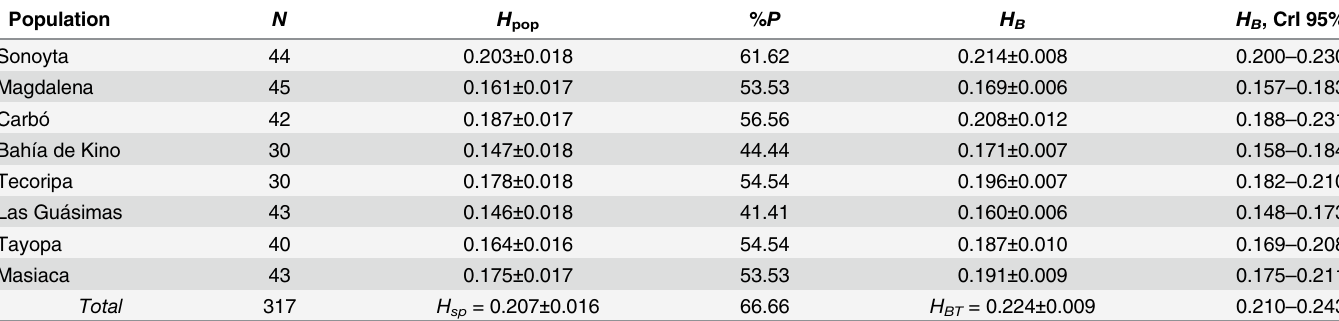
Table 2. Total and within population genetic variation in Stenocereus thurberi .